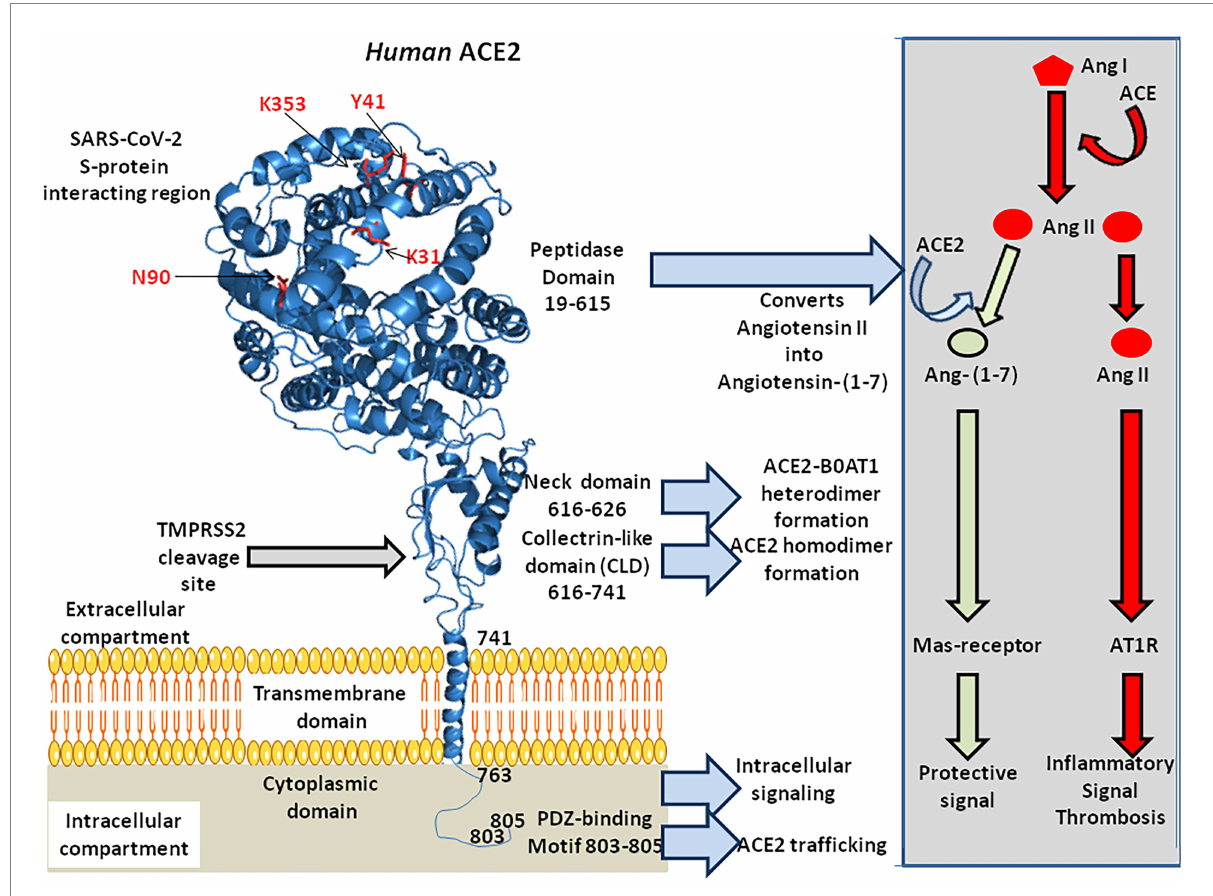
FIGURE 2 3-D model of ACE2 protein structure according to the published data PDB: 6M1D by Yan and colleagues in 2020. ACE2 is composed of 805 amino acids and characterized by an N-terminal signal peptide of 17 amino acid residues, a peptidase domain (PD; residues 19–615) with its HEXXH zinc binding metalloprotease motif, a C-terminal collectrin-like domain (CLD; residues 616–741) that includes a ferredoxin-like fold “neck” domain (616–626), that end with a hydrophobic transmembrane hydrophobic helix region (741–763) followed by an intracellular segment of 43 amino acid residues. No information is available regarding the 3-D structure of the ACE2 cytoplasmic tail (763–805), which was drawn to appear on the diagram. Some of the amino acids which are considered important for SARS-CoV-2 interaction are located in the 3-D model (amino acids in red). Arg 652 , Arg 708 , and Arg 710 (not shown) are the active residues for ACE2-TMPRSS2 docking. The function of each domain is indicated on the middle right side of the figure. The biochemical pathway of the RAS and the beneficial ACE2/Ang-(1–7) arm of RAS are summarized in the right